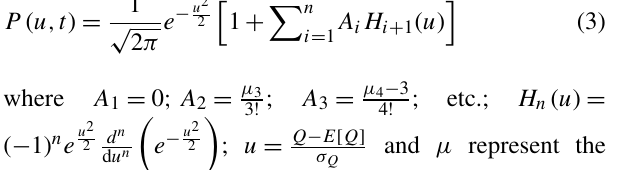
Figure 3. Calibration and validation of the investigated ensemble models in the Mono basin at